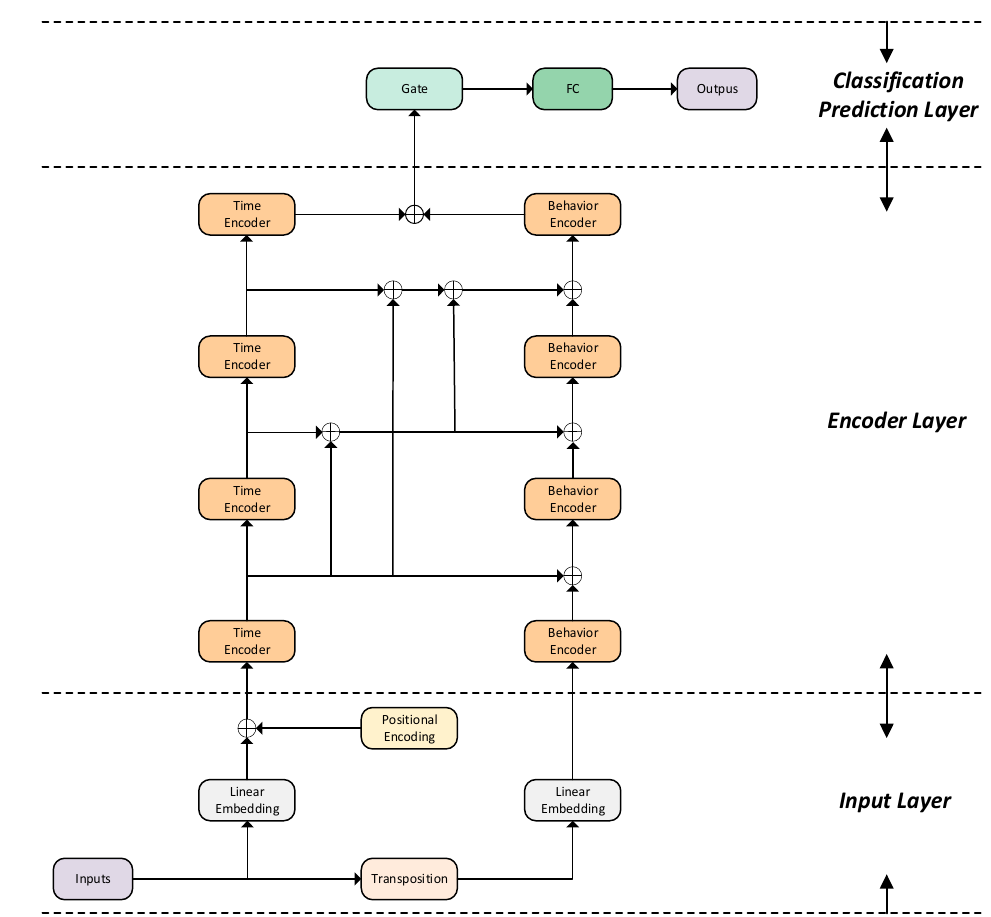
Figure 1. Model architecture of the two-stream informer